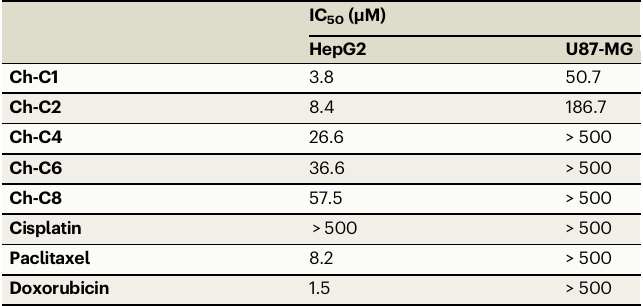
Table 2 | IC 50 values ( μ M) for Ch-Cn (n = 1 – 8) against